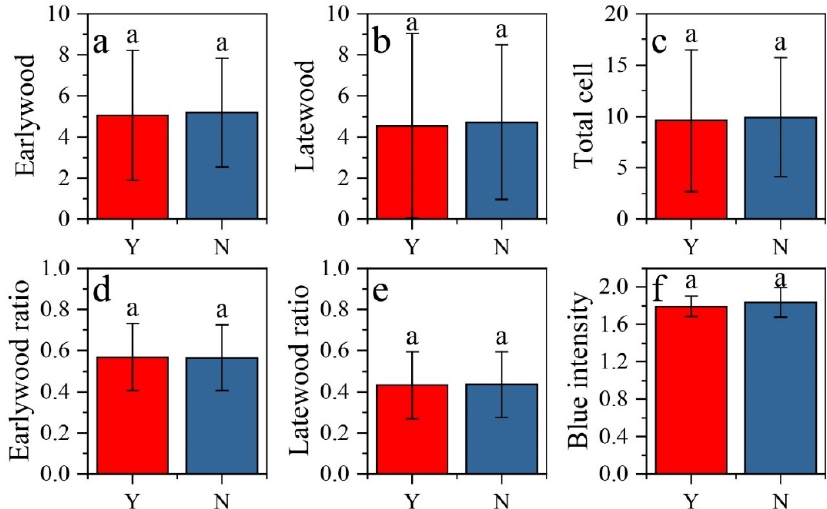
Figure 4. Comparison of the cell numbers of ( a ) earlywood and ( b ) latewood and ( c ) total cells and ( d ) earlywood ratio, ( e ) latewood ratio and ( f ) blue intensity of latewood between trees with (Y red) and without (N blue) the heat-protecting. a, b—different letters indicate significant differences. Values are mean ± standard error (sample size n = 8).